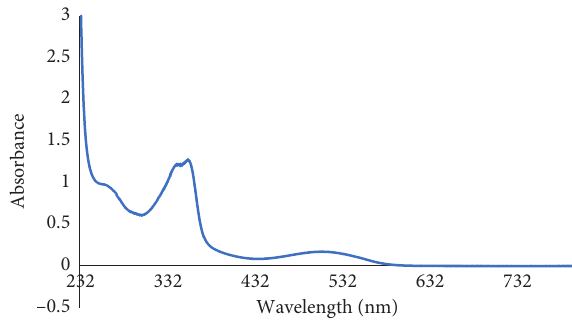
Figure 6: UV-Vis spectra for complex C3 .